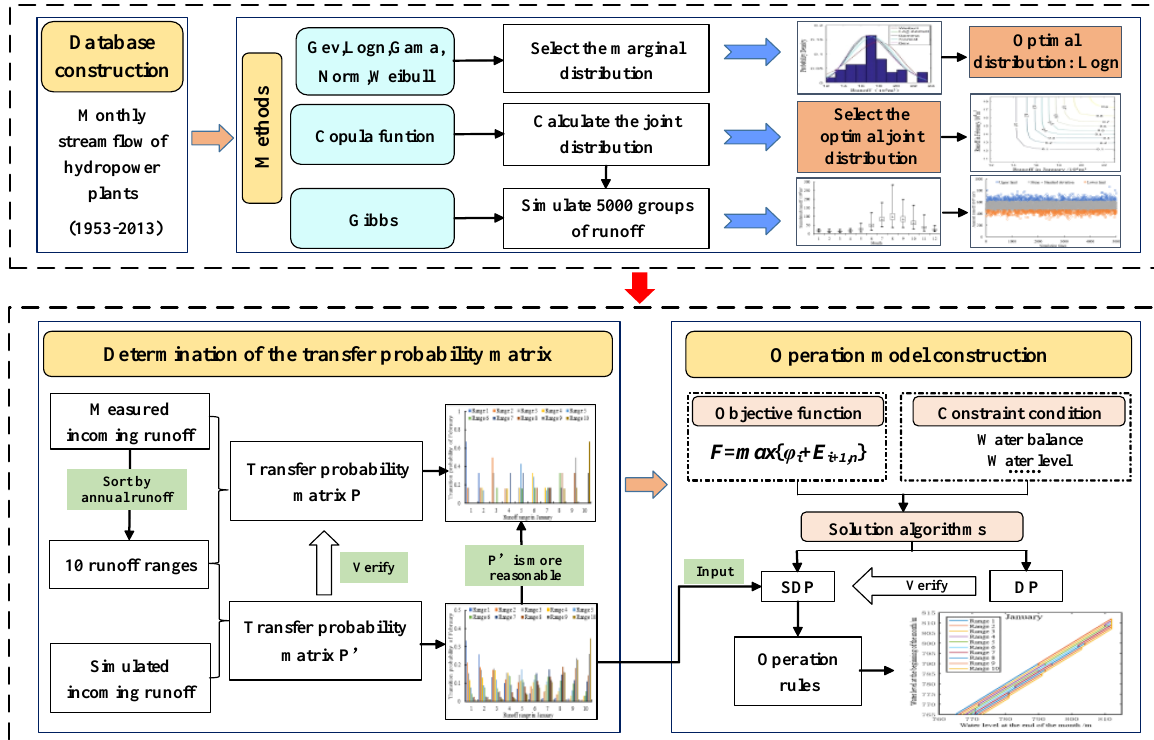
Figure 3. The framework of the main research content.